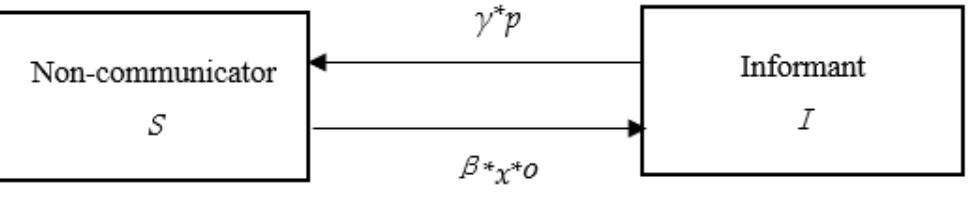
Figure 1. User SIS Transition Diagram.